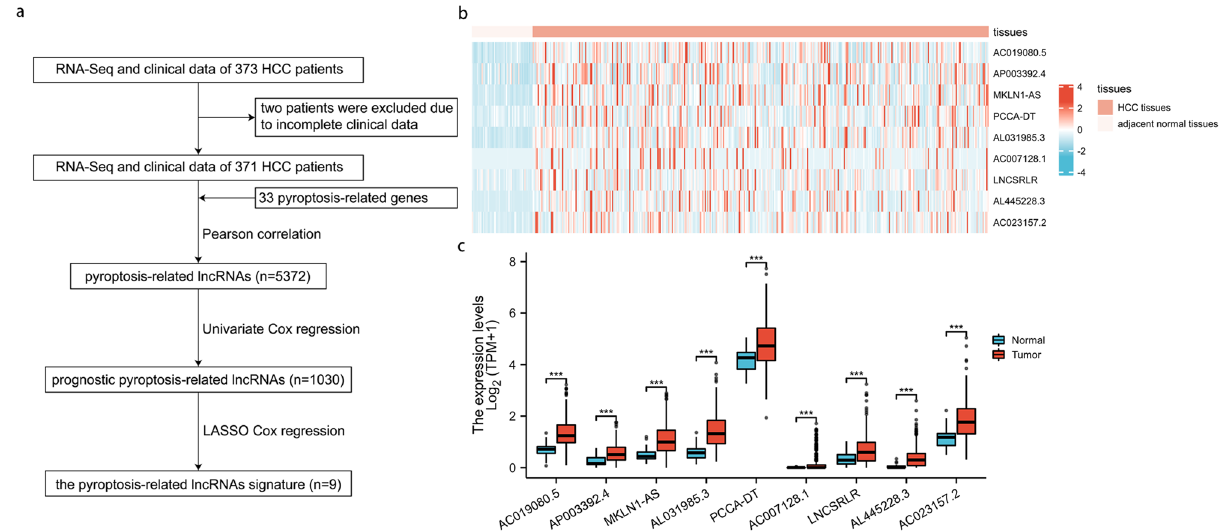
Figure 1. Identification of the pyroptosis-associated lncRNAs in HCC patients. ( a ) The flow chart of constructing the pyroptosis-related lncRNAs signature. ( b ) The heatmap of 9 prognostic pyroptosis-related lncRNAs in HCC tissues and adjacent normal tissues. ( c ) The barplots comparing the 9 prognostic pyroptosis- related lncRNAs between HCC tissues and adjacent normal tissues. HCC, hepatocellular carcinoma. *P < 0.05; **P < 0.01; ***P <